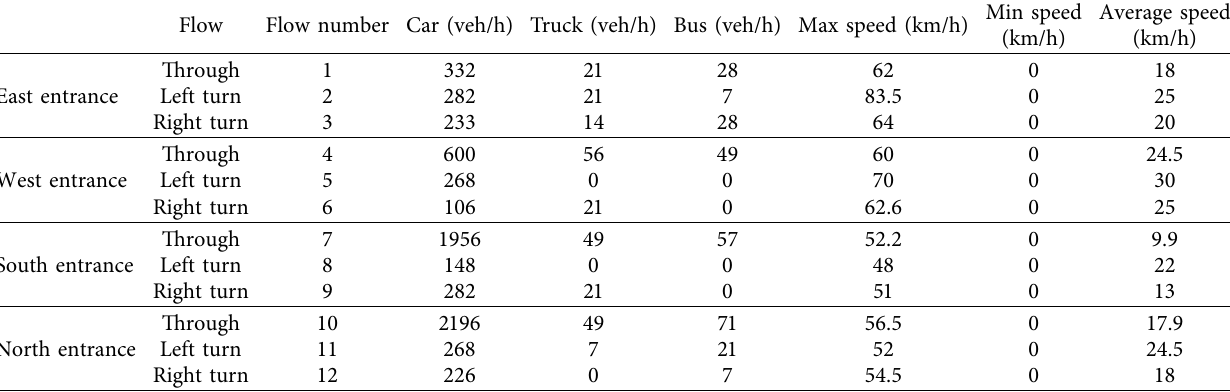
Table 2: Collected data during the peak hour of 11:00 a.m. to 12:00 a.m. on 21 October 2020. Flow